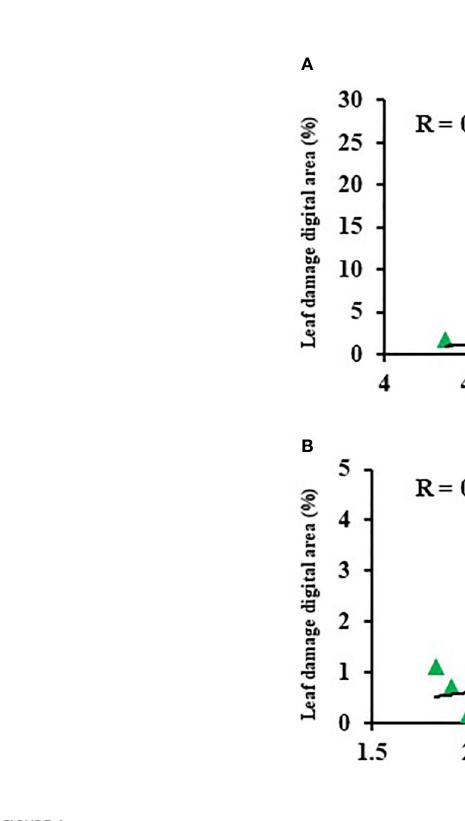
FIGURE 4 Correlations between disease score and leaf damage digital area at 96 hours post inoculation with Peyronellaea pinodes (A) and Didymella pinodella (B) . The asterisks show the signi fi cance level (* p <